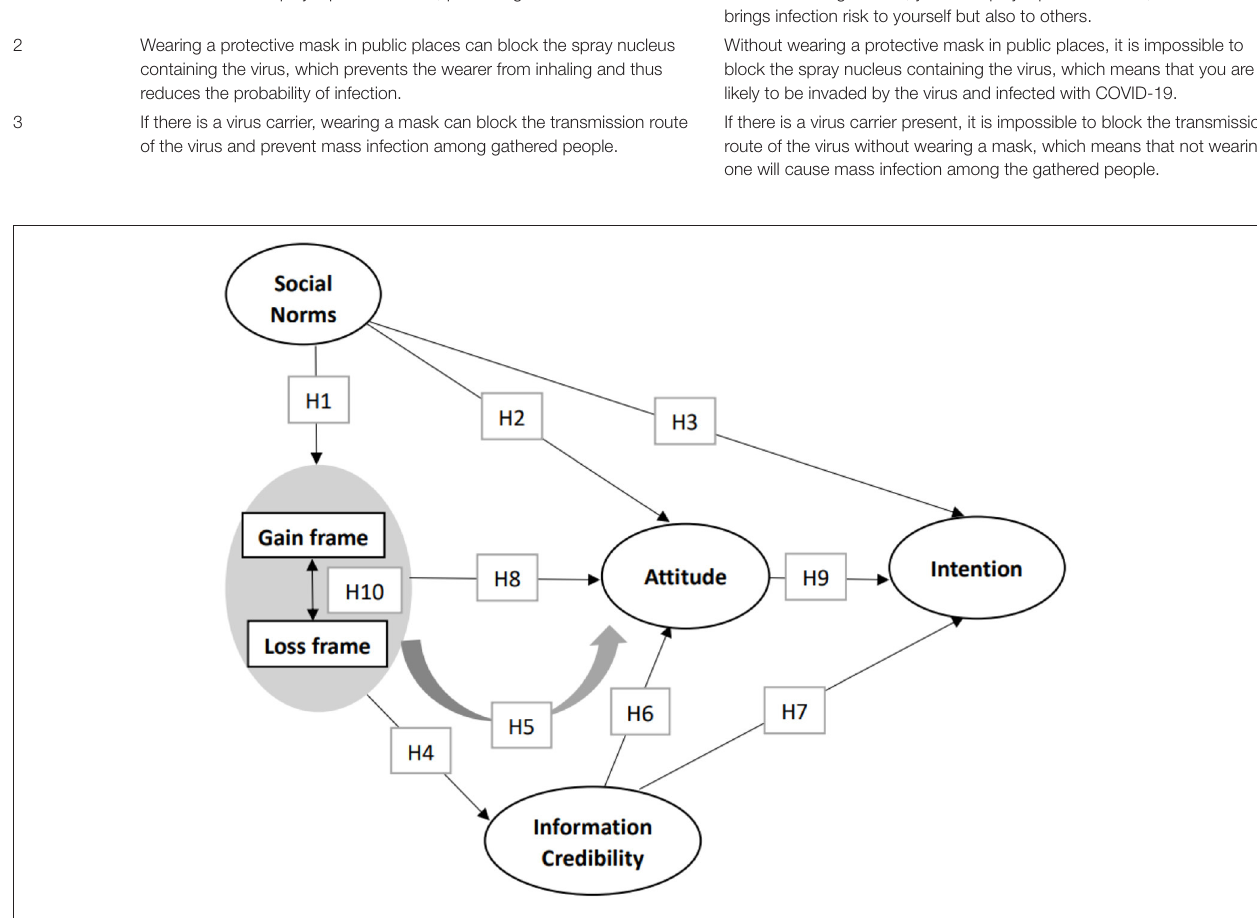
FIGURE 1 | Structural equation model of this